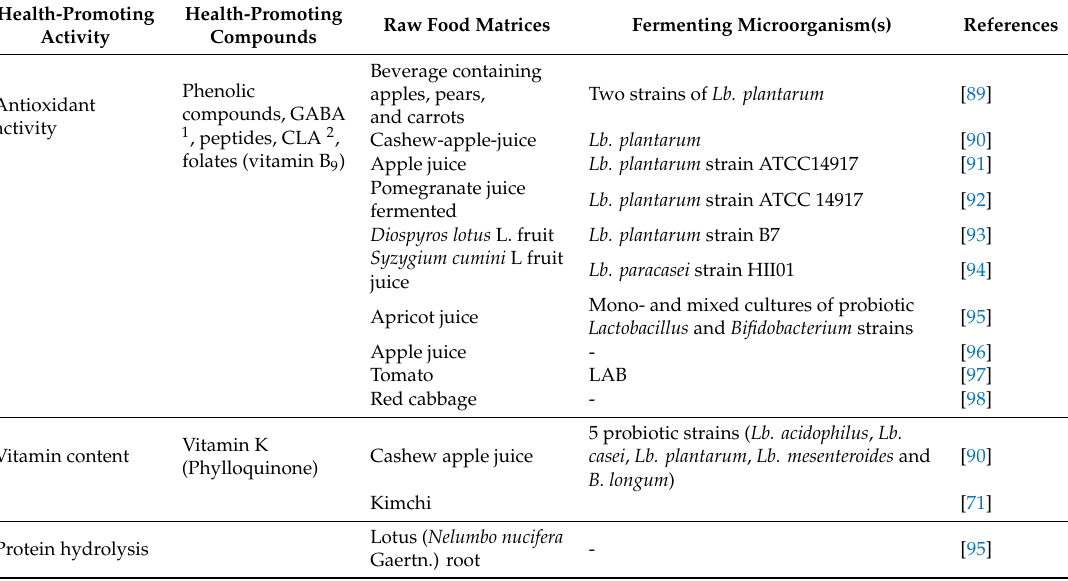
Table 4. Health-promoting compounds in fermented fruit and